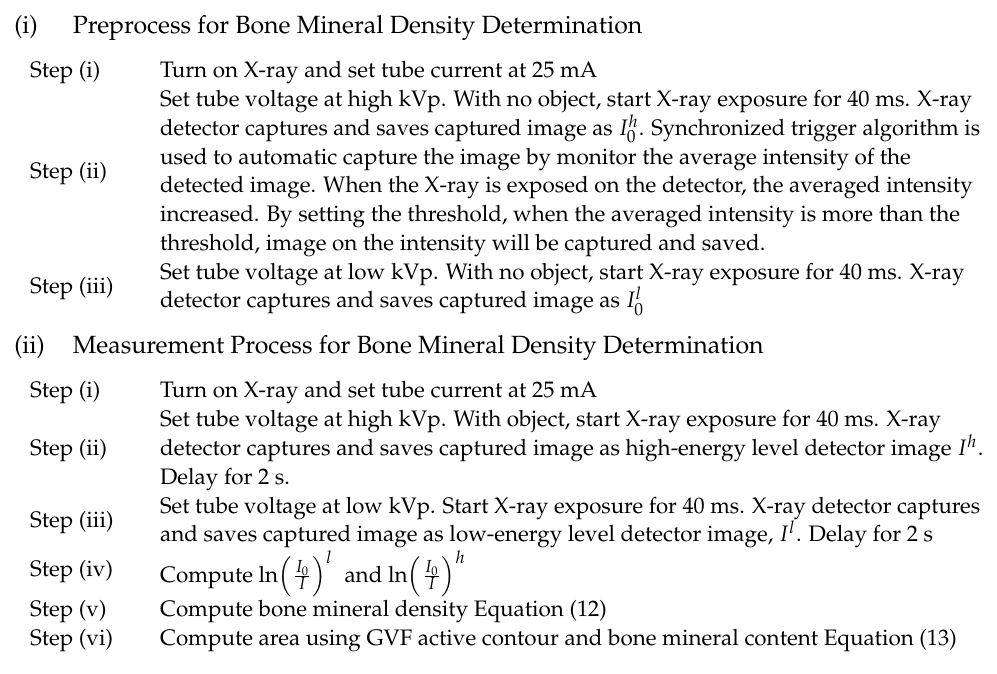
Figure 7. Active contour used to find the contour of middle phalanges of middle finger.